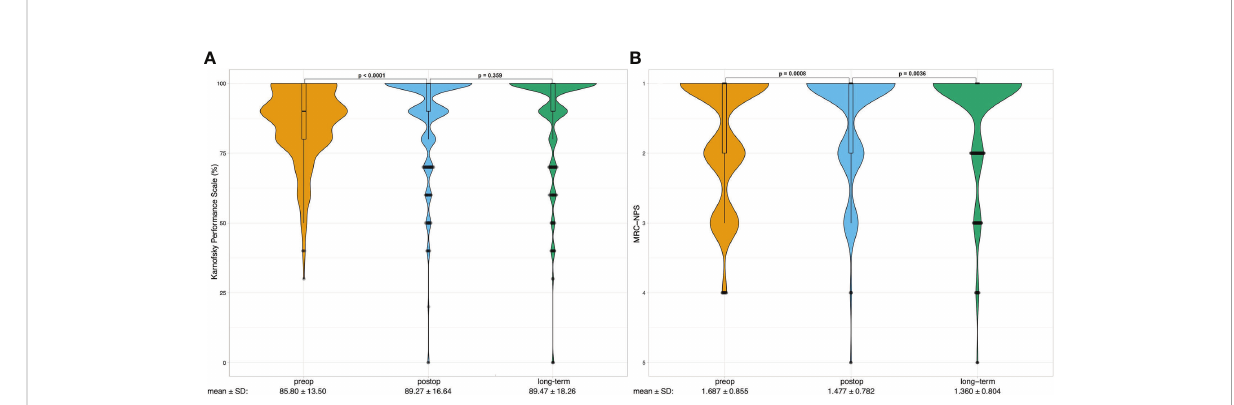
FIGURE 2 Violin plots show the distribution of preoperative (preop, yellow), postoperative (postop, blue) long-term (last follow-up, green) (A) Karnofsky Performance Scale (KPS) scores and (B) Medical Research Council - Neurological Performance Scale scores of the analyzed patients (n=300). Boxplots are shown within violin plots depicting median with lower and upper quartiles. Whiskers represent 1.5 interquartile range. Outliers are depicted as points. One-way repeated measure ANOVA was calculated to analyze the difference between preop, postop and long-term performance, the p – values are noted on top of the graph. Below the plots mean scores with standard deviations (SD) are